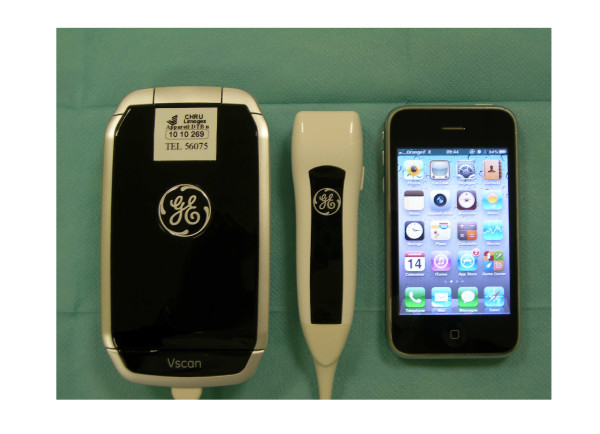
New generation miniaturized ultrasound system the size of a smartphone used in the current study.